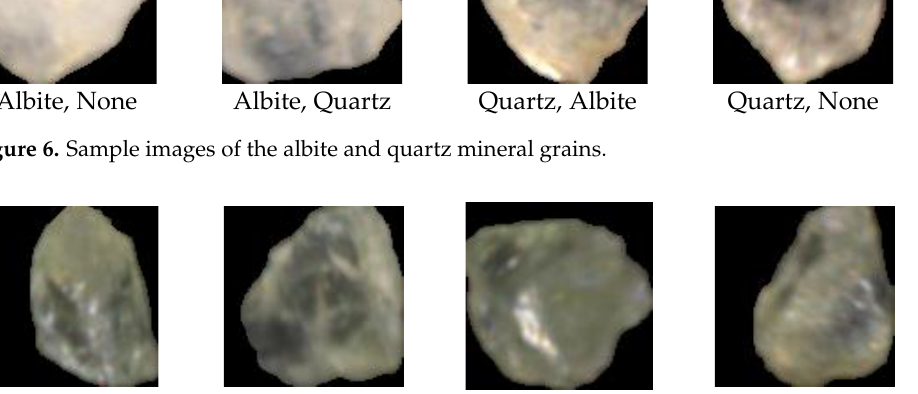
Augite, None Augite, None Augite, None Figure 7. Sample images of the augite and tschermakite mineral grains. Figure 7. Sample images of the augite and tschermakite mineral grains. Figure 7. Sample images of the augite and tschermakite mineral grains. Figure 7. Sample images of the augite and tschermakite mineral grains.